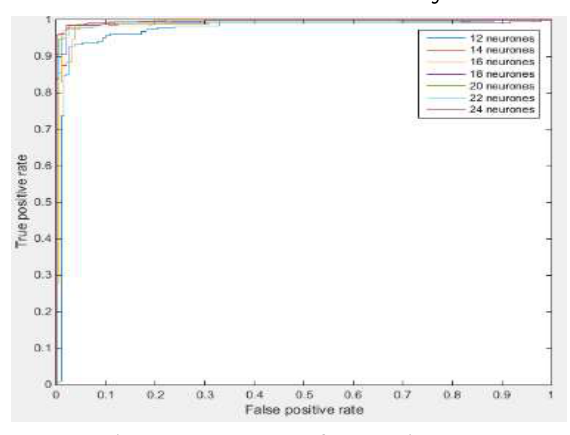
Figure 28. ROC curve for experiment 2.